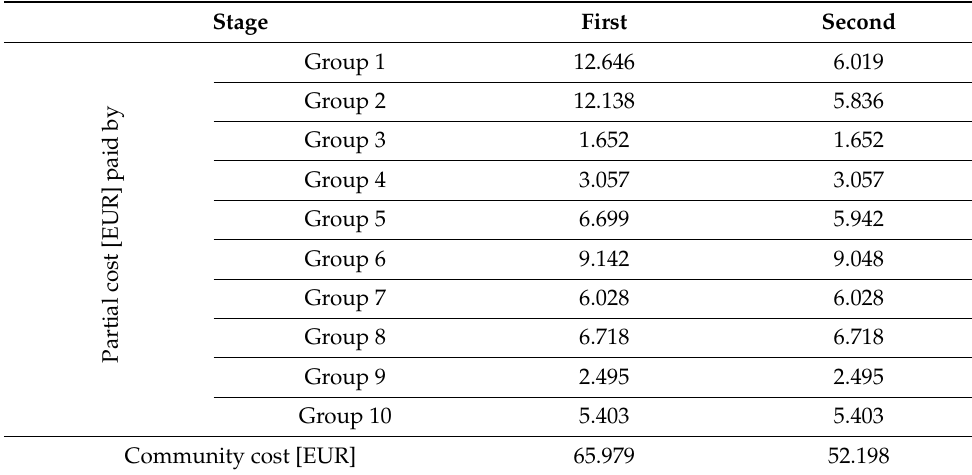
Figure 11. Case B. Amount of energy surplus computed by the first stage and amount of energy surplus redistributed to the groups by the second stage. Table 7. Case B. Energy cost incurred by the single groups and the community, after the first and second